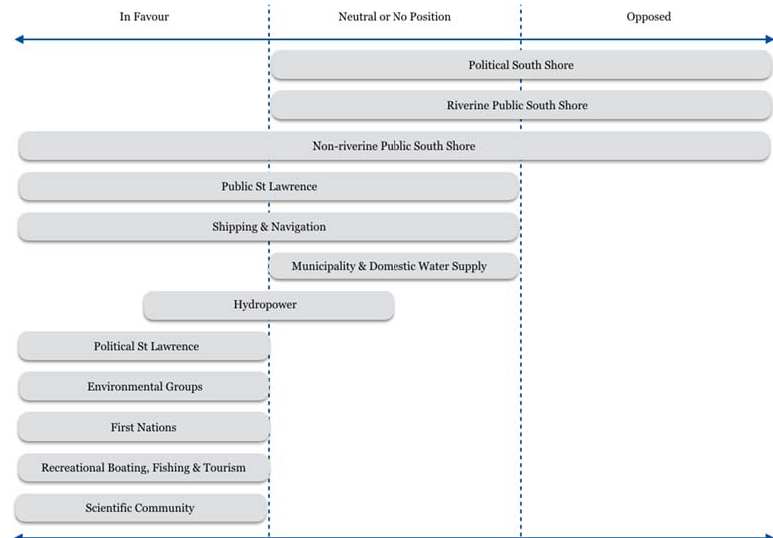
Figure 2. Final position of stakeholders on Plan 2014.